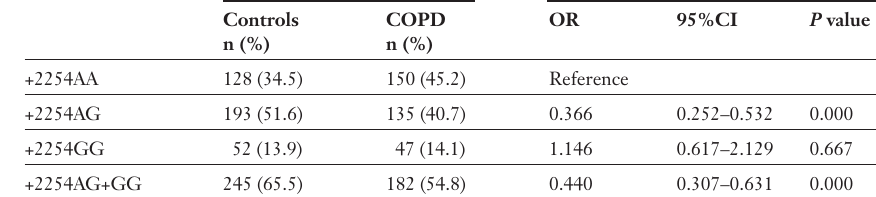
Genotype distribution of +2254A>G SNP in controls and COPD patients.